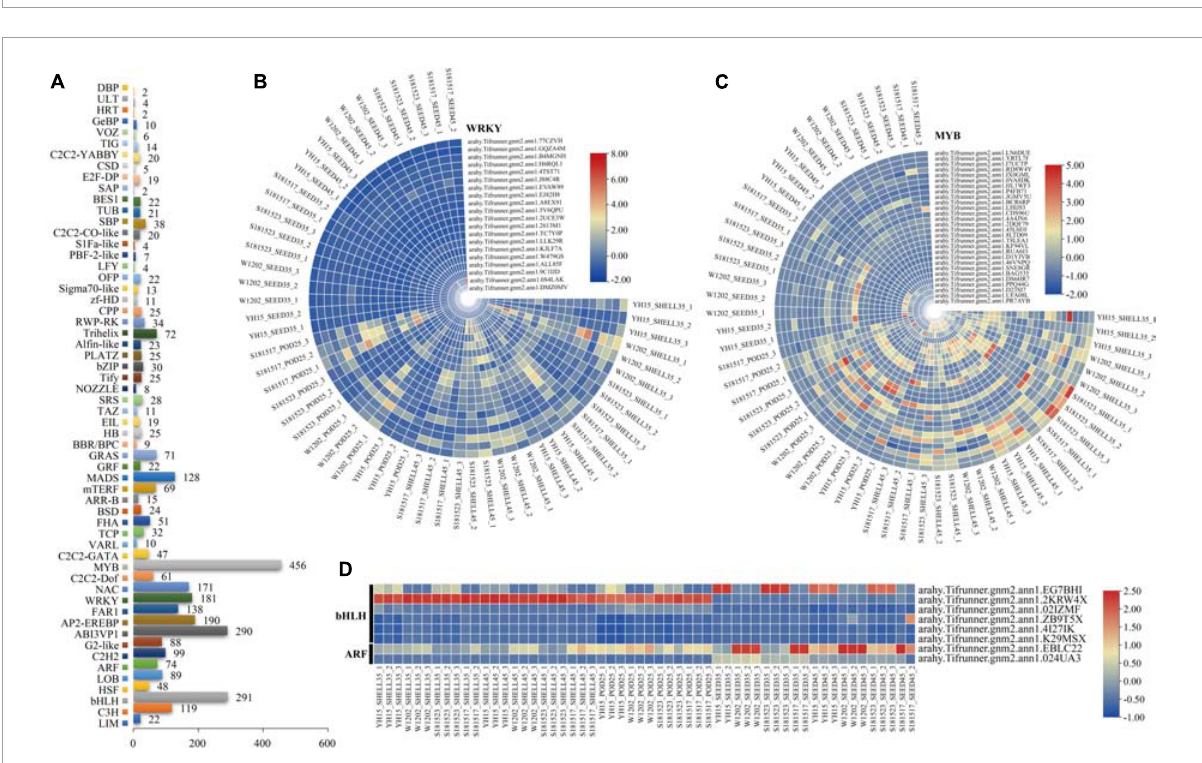
FIGURE7 Identification of DEGs related to transcription factors (TFs). (A) Number of TFs expressed. (B–D) Heat map of relative expression of WRKY, MYB, bHLH, and ARF TF family DEGs. From red to blue, it indicates that the relative expression level is from high to low.